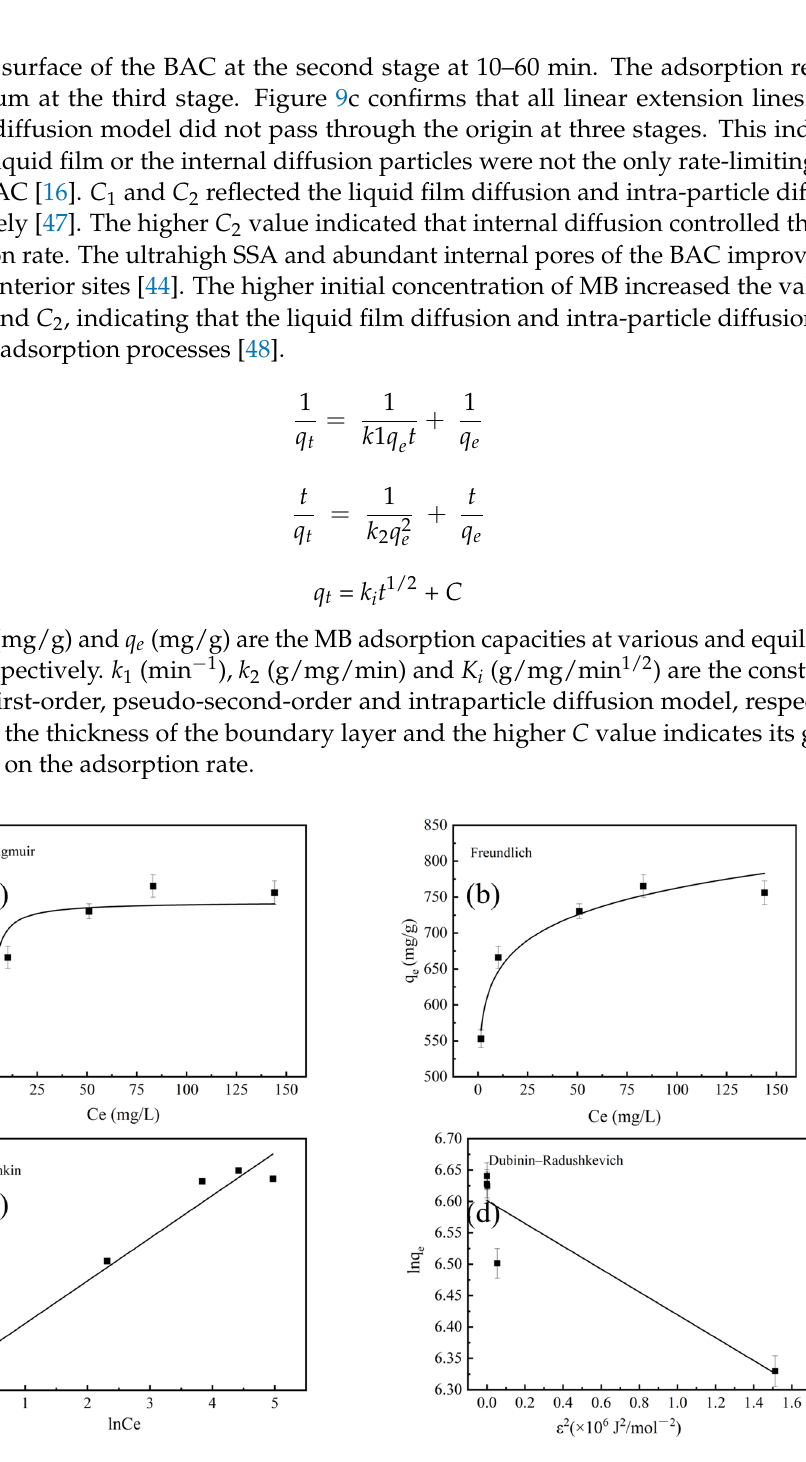
Figure 8. Fitting lines of the BAC at 298 K with Langmuir ( a ), Freundlich ( b ), Temkin isotherm models ( c ) and Dubinin–Radushkevich ( d ). Table 2. Isotherm parameters for adsorption of the BAC.